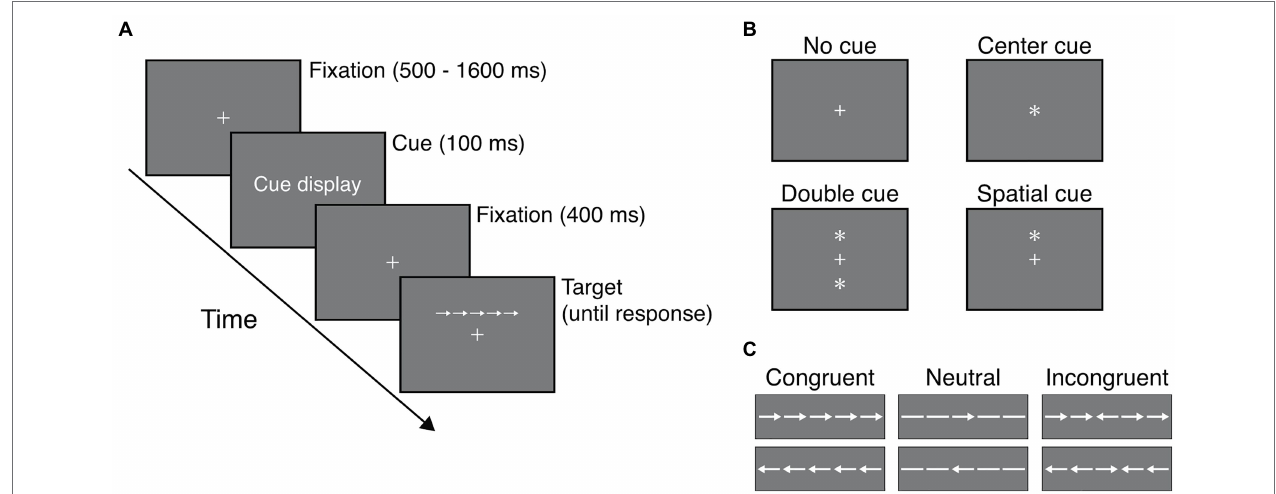
FIGURE 1 | Example of a trial in the Attention Network Test. (A) Sequence of trial events. In the “Cue display,” one of the four cues was presented. For the “Target” period, one of the stimuli was presented above or below the fixation cross. (B) The four cue conditions. (C) The three stimulus conditions. The center arrow of each stimulus was the